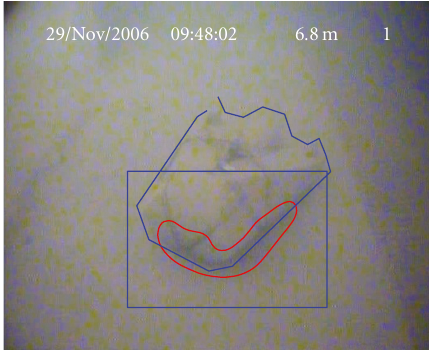
Figure 19: Segmentation of a gray mine at sea. C good = 0 . 25 and C false = 0 .